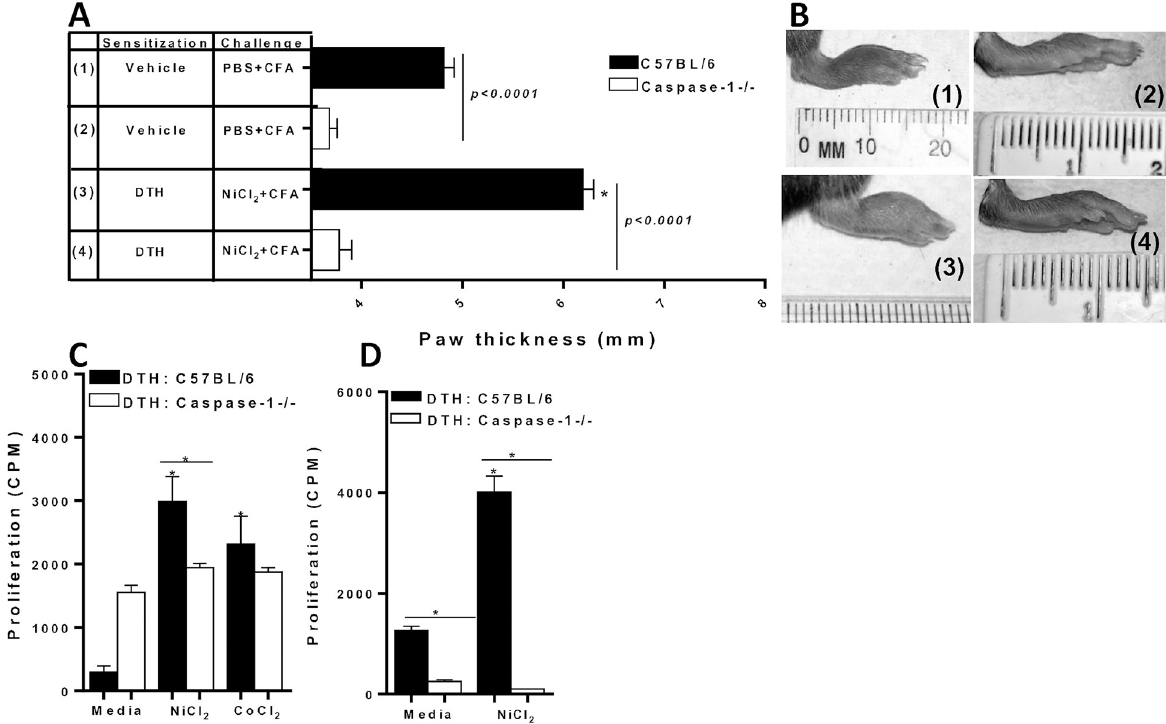
Fig 4. Caspase-1-/- mice do not exhibit metal-DTH reactivity in vivo or in vitro . (A) DTH was determined by measuring paw thickness 48 h after challenge (D 14) in mice groups 1–4 that were sensitized and challenged as indicated on D 12 and (B) corresponding representative photographs (correspond to label group numbers 1–4) of inflammatory lesions in the paw of vehicle- and metal-DTH treated C57BL/6 or Caspase-1-/- mice. At D 14, spleens were harvested co-cultured with or without Ni (0.001mM) or Co (0.001mM) challenge for four days. (C) Proliferation of splenocytes was measured by 3H-thymidine incorporation. CD4+ T cells were purified from either DTH C57BL/6 or DTH Caspase-1-/- mouse spleens and co-cultured with mitomycin-C treated na ï ve total spleen cells from C57BL/6 or Caspase-1-/- mice respectively, with Ni (0.001mM) challenge for four days. (D) Proliferation of CD4+ T cells was measured by 3 H-thymidine incorporation. Data represent one of three independent experiments with 3–4 mice/group in each experiment. Data are shown as mean ± SEM. Statistical significance was determined by Student’s unpaired two-tailed t-test ( � P �